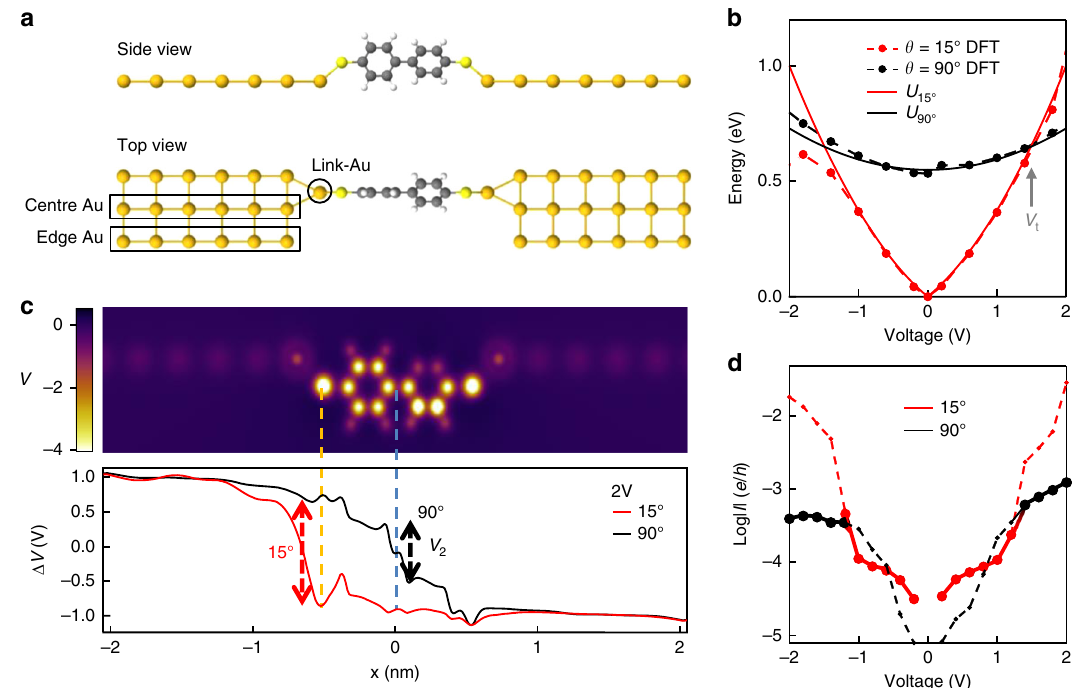
Fig. 4 Modelling of junction under bias. a Model DFT geometry shown for θ = 15°, Au and S atoms remain fi xed when changing θ . b DFT energy for θ = 90° is lower than θ = 15° for V > 1.5 V, while U 15 (cid:2) , U 90 (cid:2) calculated from bond capacitances and dipoles (dashed) follow DFT, predicting con fi guration switch at V t (cid:3) 1.5 V. c Potential distributions in atoms at the molecule-lead interface for θ = 15°. Applied potential Δ V drops predominantly across central C – C bond for θ = 90°, and across one Au – S interface for θ = 15°. d Calculated tunnelling between the leads, showing lack of twisting signature at V t